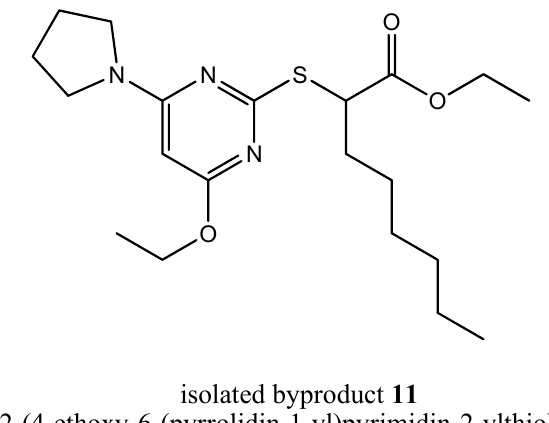
Figure 6. Chemical structure of the isolated byproduct 11